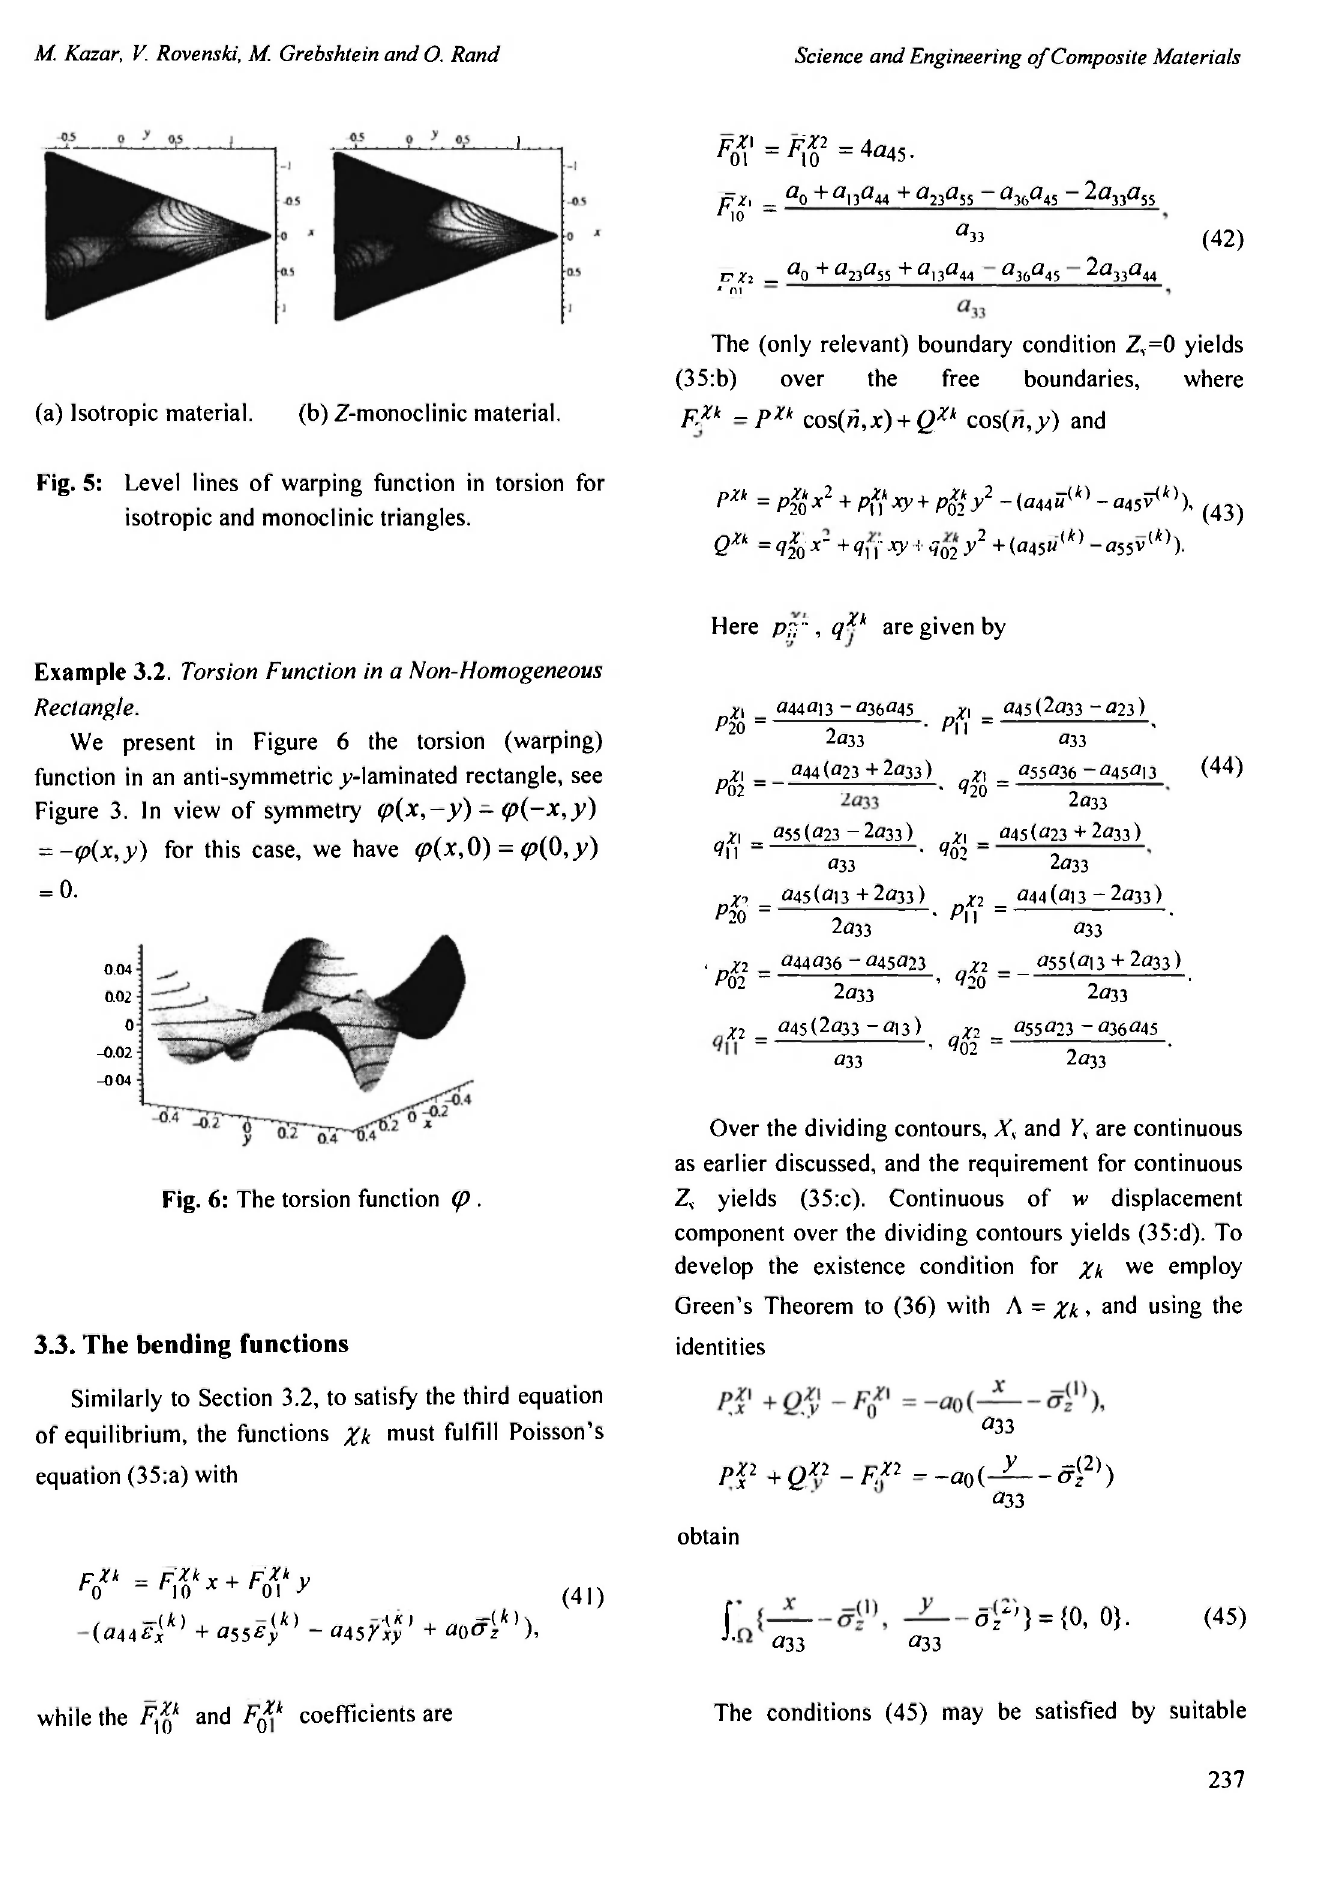
Fig. 5: Level lines of warping function in torsion for isotropic and monoclinic triangles.